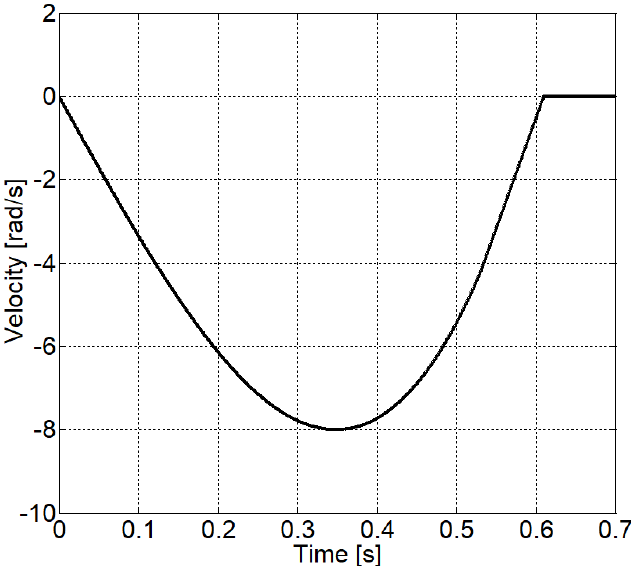
Figure 12. System’s velocity with both input and velocity